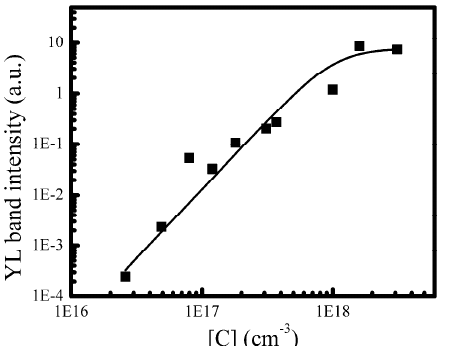
Figure 6. Dependence of YL band of ten u-GaN samples on the carbon concentration. The black line is used to declare the trends.